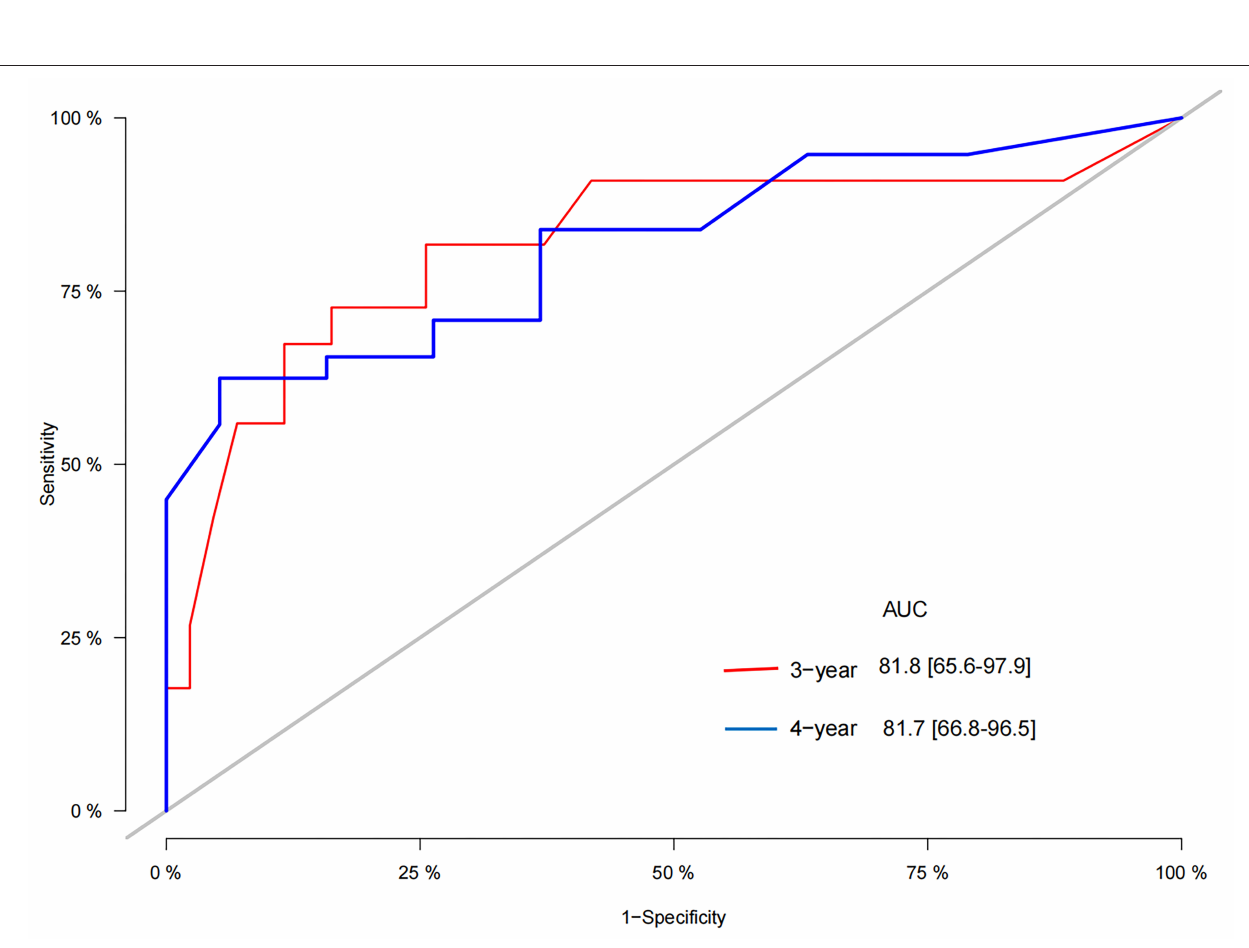
FIGURE 5 | The AUC of 3-and 4-year of children in the CHCMU.